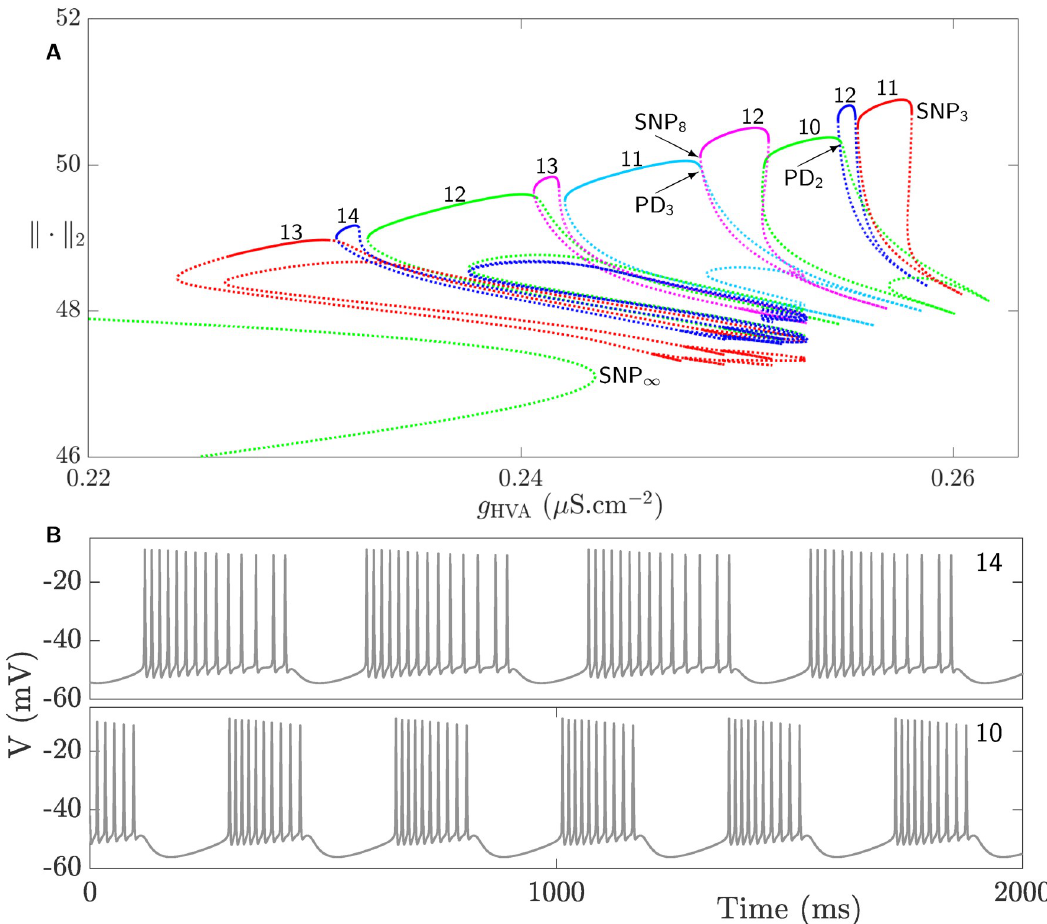
Fig 6. Square-wave bursting in the CSC model defined by the full system (1) when g HVA is varied. A ). Magnification of the set of isolas of square-wave BPOs shown within the box in Fig 5 A . Each isola is an envelope of stable periodic orbits (solid) on the top that becomes unstable (dotted) either at a saddle-node bifurcation of periodic orbits ( SNP i , i = 3, ... ) or period-doubling bifurcation ( PD j , j = 1, ... ) to the right and left of each isola in a non-orchestrated manner (i.e., in a non-consistent pattern). The number of spikes of active phases of BPOs associated with these isolas is indicated with a number on top. B ) Time courses of two square-wave BPOs when the number of spikes per burst is 14 (top) and 10 (bottom) obtained at g HVA = 0.232 μ S.cm − 2 and g HVA = 0.253 μ S.cm − 2 ,